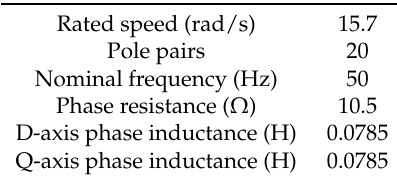
Table 2. Electrical generator model parameters.